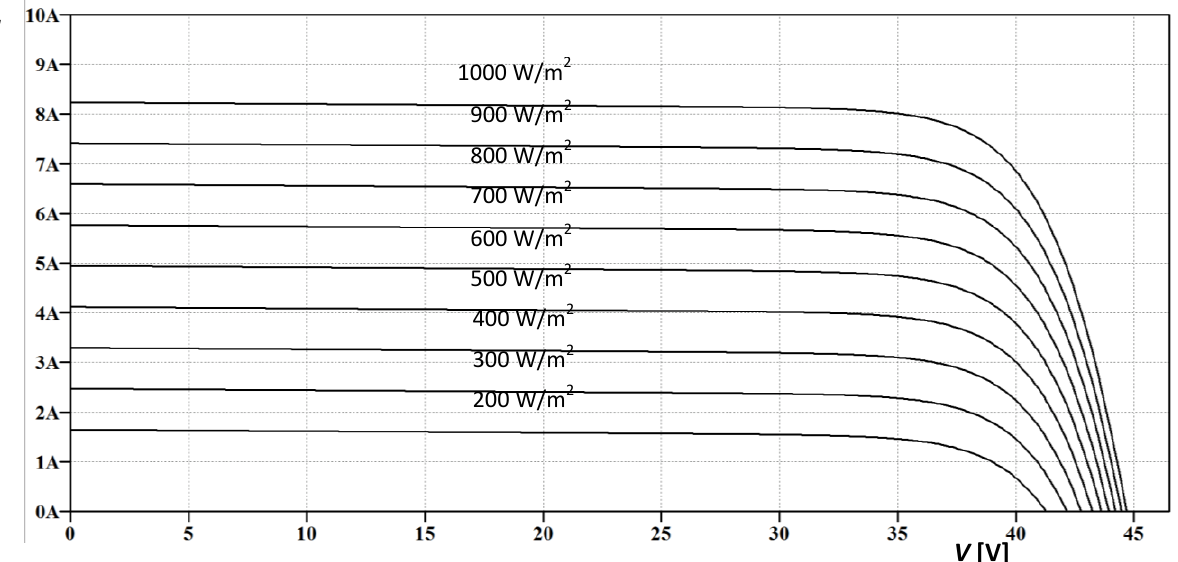
Figure 8. I-V curves of panel MSMD290AS-36.EU simulated with LTSpice calculation of the equivalent circuits for different irradiation levels, from 200 W/m 2 to 1000 W/m 2 , at 25